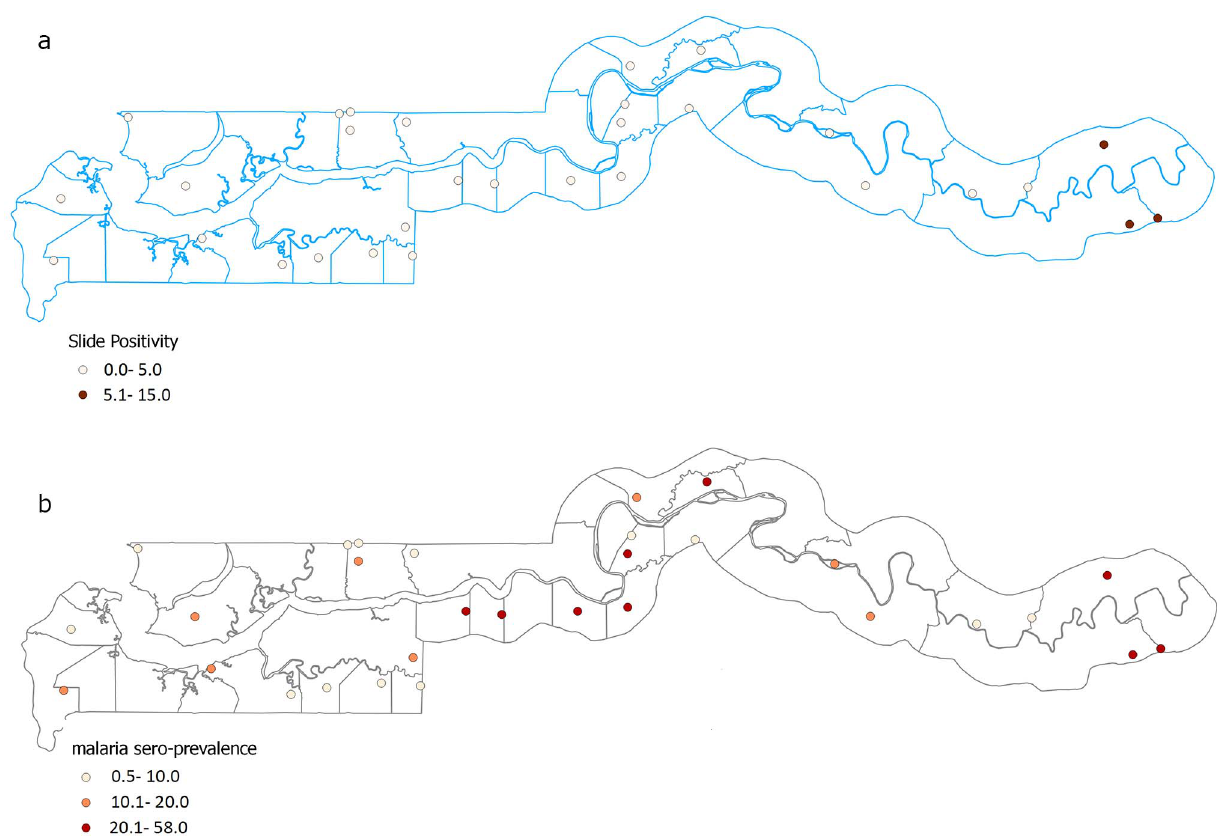
Figure 2. Slide positivity and seroprevalence rates for sampled schools. Circles represent schools location and colour graded according to the inset showing the prevalence of individuals with a positive blood slide for P. falciparum (A) and positive for antibodies to MSP1 19 (B).